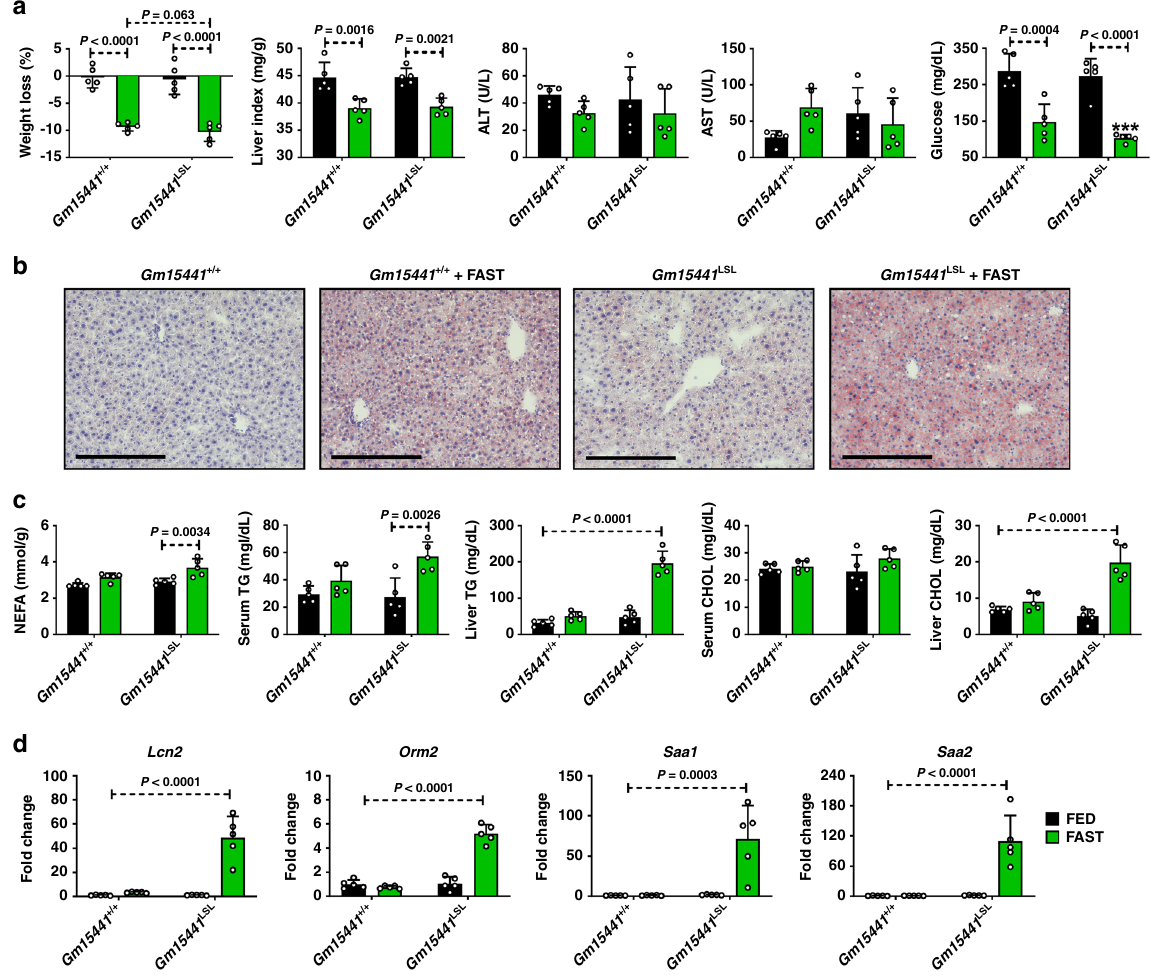
Fig. 6 Loss of Gm15441 potentiates in fl ammasome activation during physiological response to acute fasting. a Physiological endpoints from Gm15441 + / + and Gm15441 LSL mice after 24h fasting. Weight loss and liver indices (mg liver/g body mass; a measure of hepatomegaly), as well as blood ALT, AST, and glucose levels, in response to fasting. b Representative ORO staining of liver tissues after a 24 h fed or fast in Gm15441 + / + and Gm15441 LSL mice ( n = 5, 3 images/mouse). Scale bars represents 100 nm (×200). c Non-esteri fi ed fatty acid (NEFA) from serum, triglycerides (TG) and cholesterol (CHOL) levels from serum and liver tissues after a 24 h fast. d Analysis of Apoa4 , Bhmt , Lcn2 , Orm2 , Saa1 , and Saa2 mRNAs in livers of Gm15441 + / + and Gm15441 LSL mice after 24 h fasting. Each data bar represents the mean ± SD for n = 5 liver samples; green bars, 24 h fasting. Adjusted p values, provided in the panels, as determined by ANOVA with Tukey ’ s multiple comparison correction, two-sided for comparisons between fast-stimulated and unstimulated livers of the same genotype, or as shown (dashed